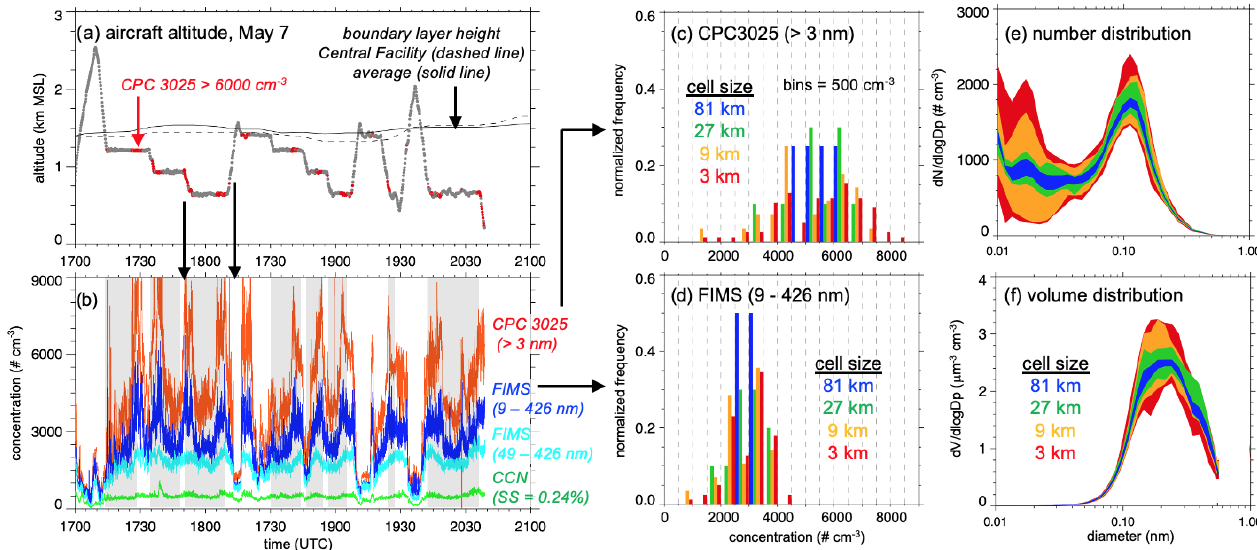
Figure 7. G-1 aircraft (a) altitude on 7 May where the alternating red colors denote locations of peak number concentrations and (b) number concentrations from the CPC3025, FIMS, and CCN instruments where the gray shading denotes boundary-layer flight legs used to com- pute subgrid-scale variability. Normalized frequency from the (c) CPC3025 and (b) FIMS instruments and the (e) number and (f) volume distribution associated with the 81, 27, 9, and 3km cell averages within the 81km cell around the SGP site.